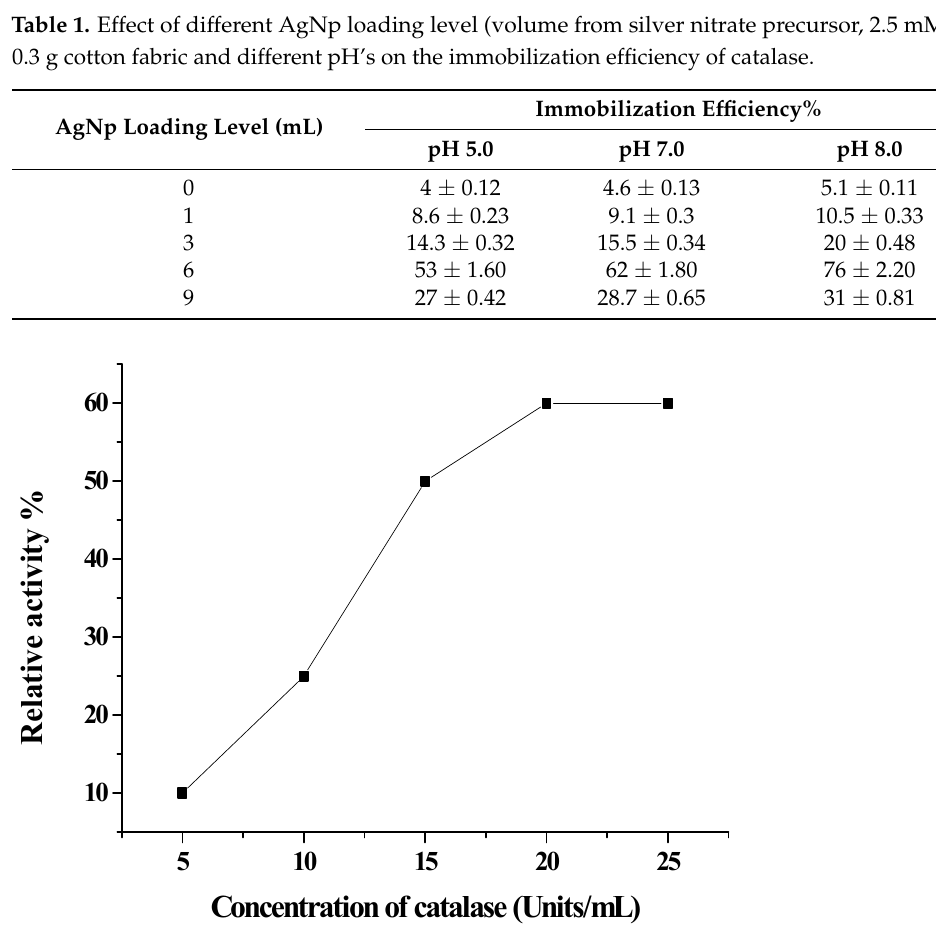
Table 1. Effect of different AgNp loading level (volume from silver nitrate precursor, 2.5 mM) per